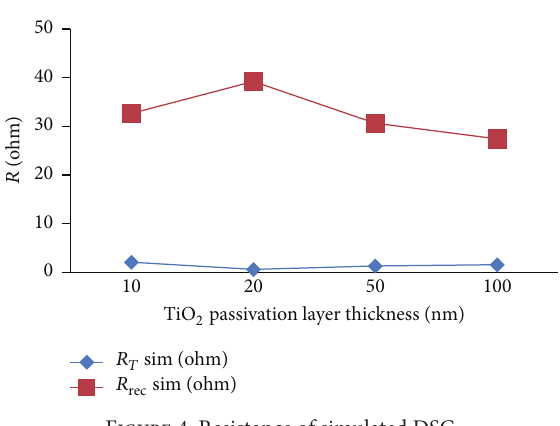
Figure 5: Efficiency of DSC with various thicknesses of TiO 2 passivation